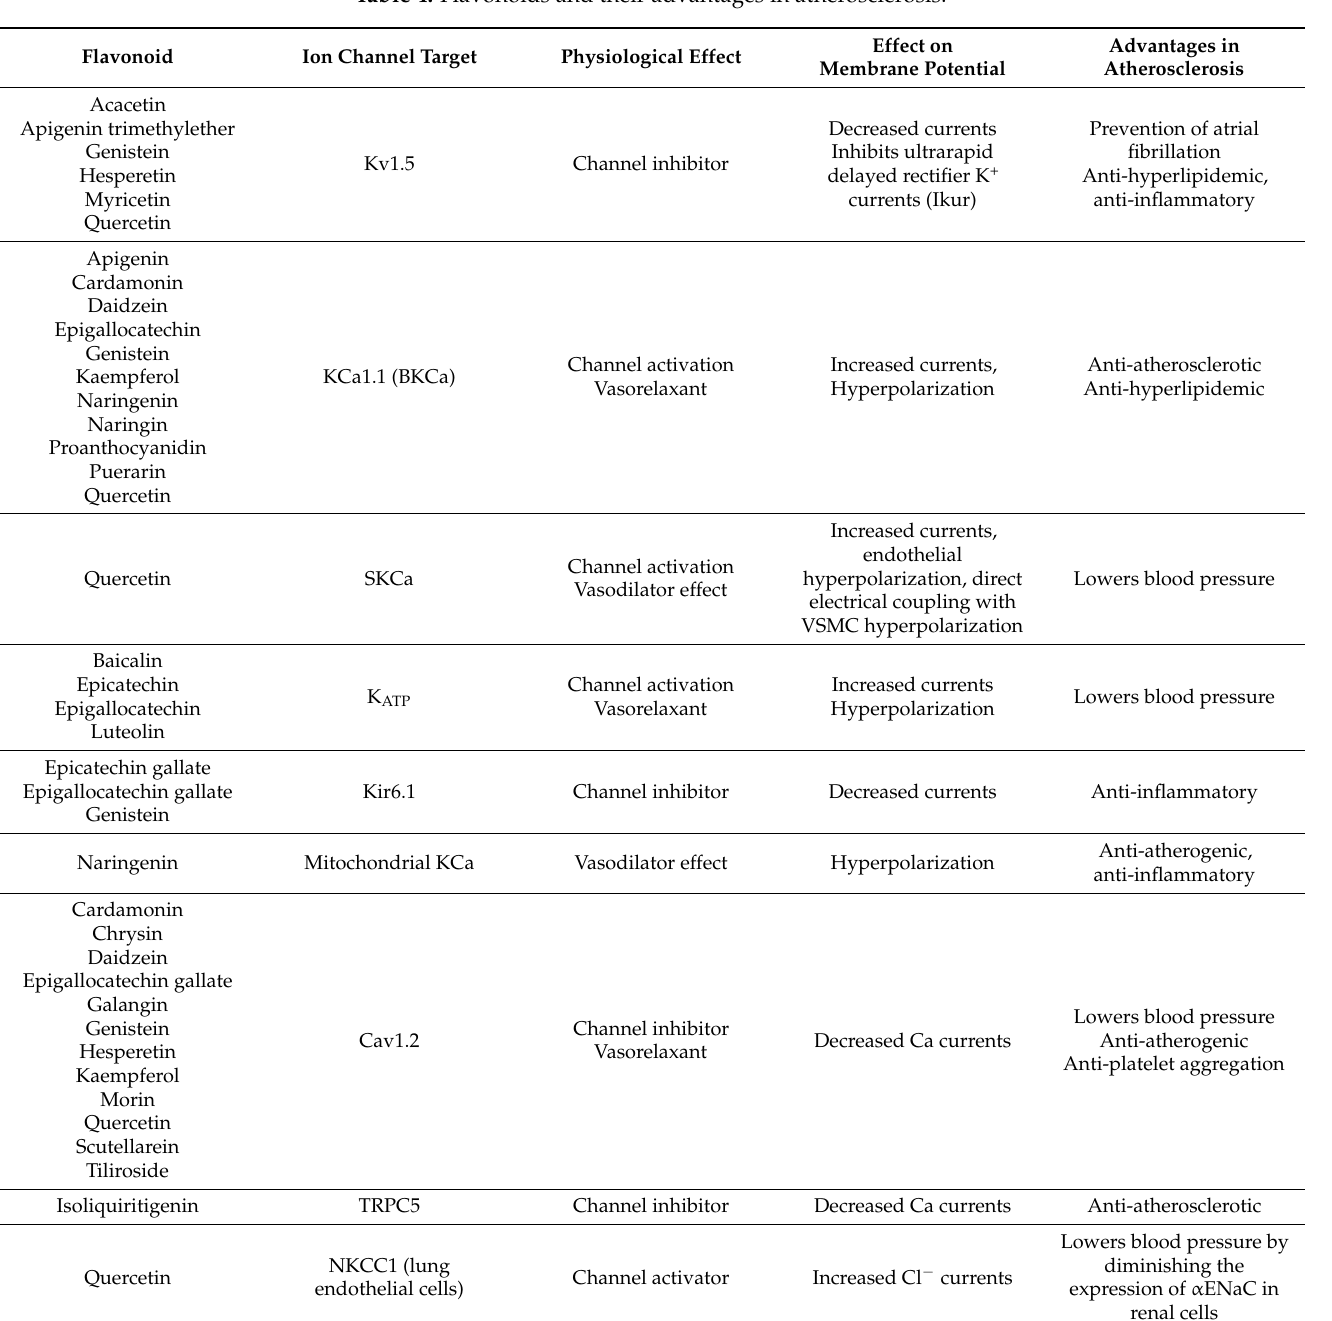
Table 4. Flavonoids and their advantages in